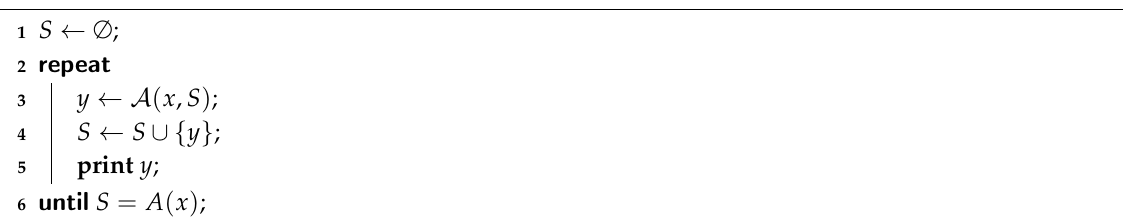
Algorithm 1: Algorithm showing para -E NUM - A ∈ CapIncFPT